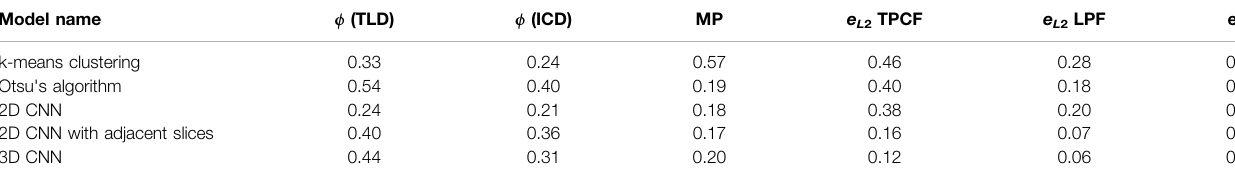
TABLE 8 | Performance of different segmentation methods applied to real npg_TLD